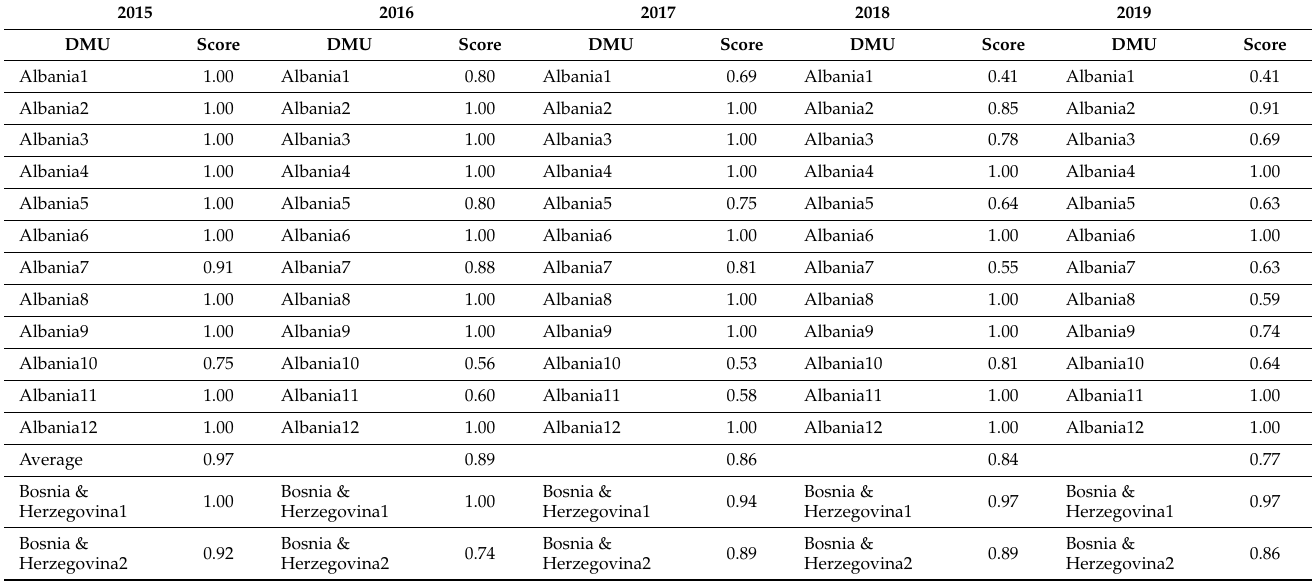
Table A1. Results of DEA model—Efficiency